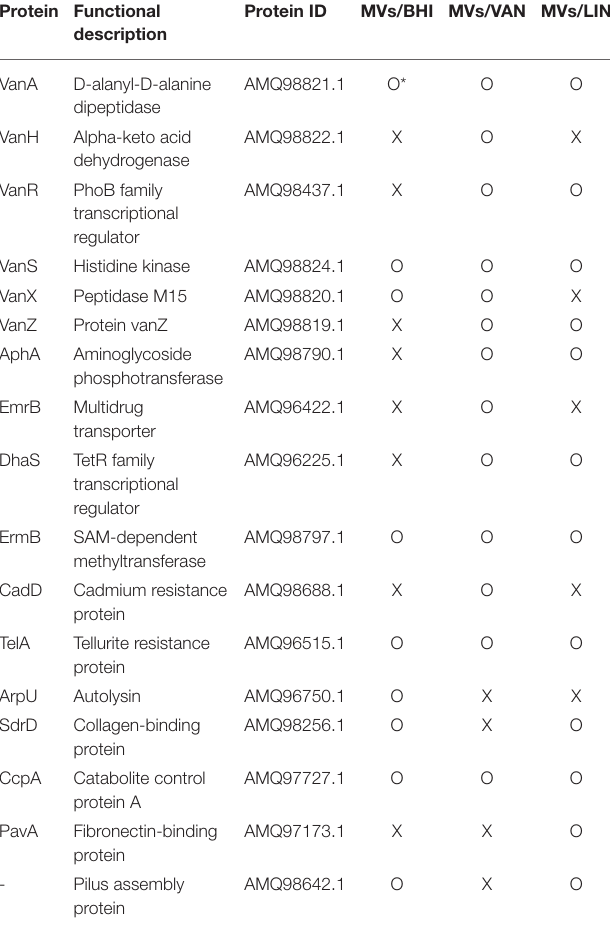
TABLE 1 | Identification of antimicrobial resistance-and virulence-associated proteins in E. faecium MVs. Protein Functional